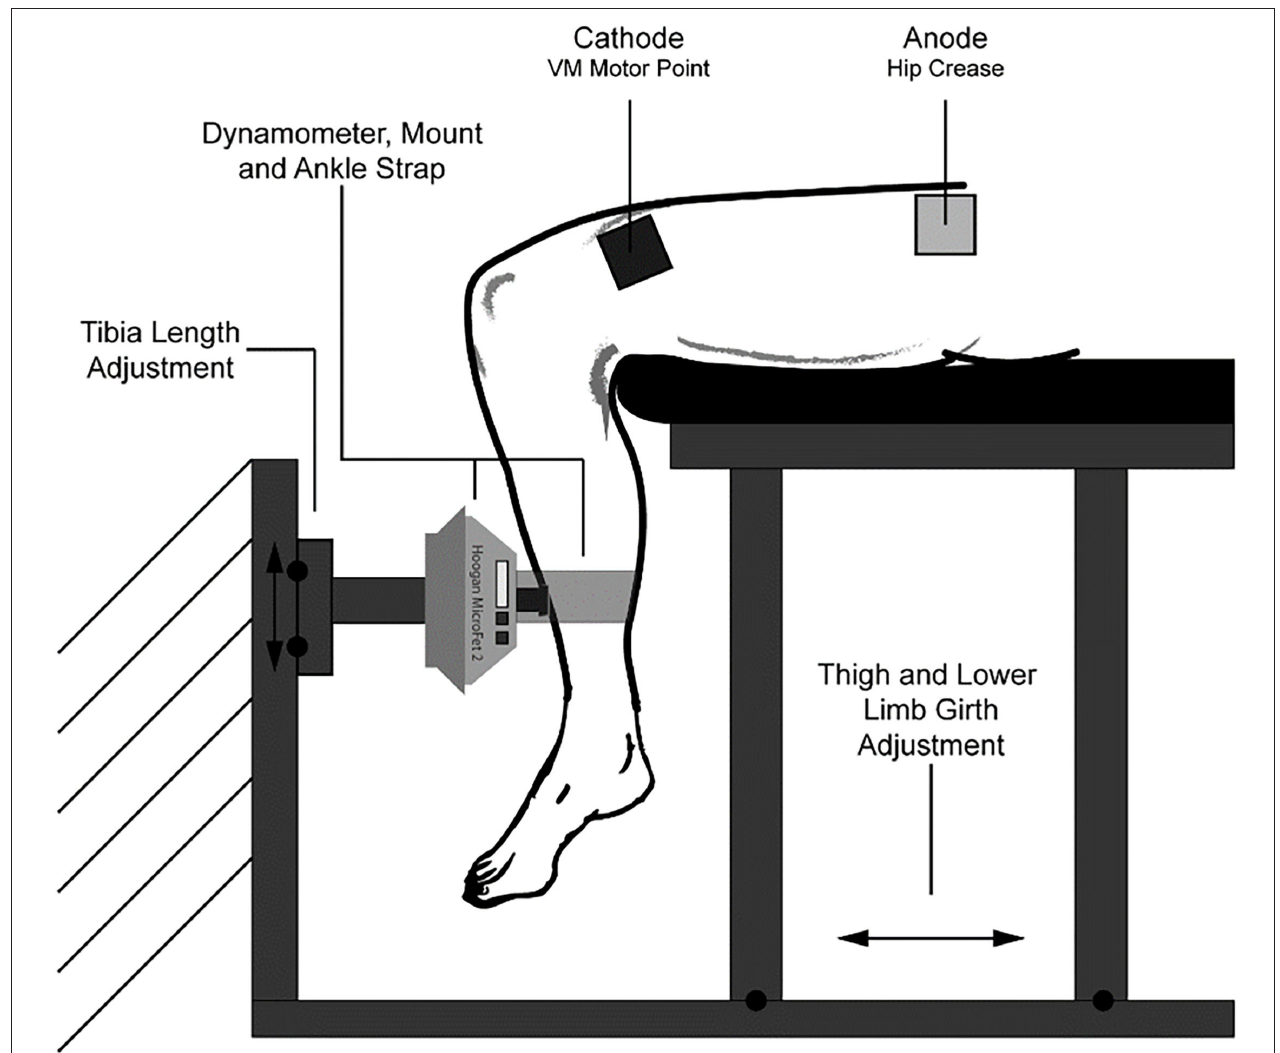
FIGURE 1 | Experimental setup. Comprised of a Hoogan MicroFET 2 dynamometer that was fastened to a rigid structure, and an adjustable seat constructed from aluminum t-slot bars. The dynamometer could be adjusted vertically to account for differences in lower limb length, and the seat could be slid along a base to adjust for subject thigh length and girth. Not depicted are a back rest and hip restraint belt. This figure was originally published in the ASCEND 2020 Conference Proceedings (Abitante et al.,